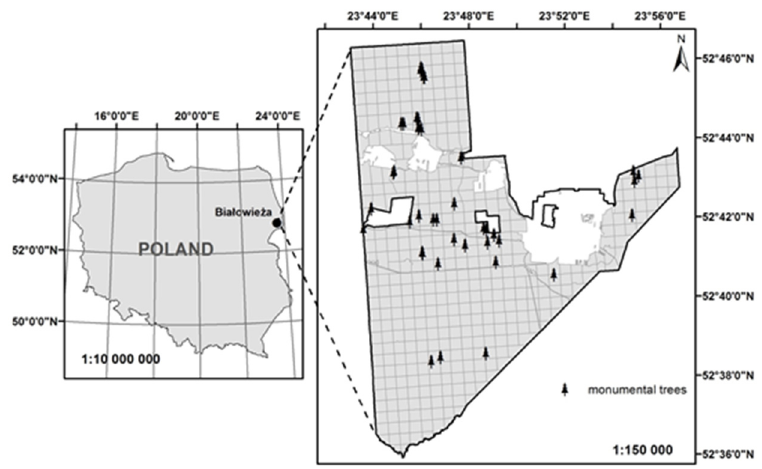
Figure 1. Geographical location of 47 Monuments of Nature (Population 1) in Białowie˙za Forest District (BFD) (a part of Białowie˙za Primeval Forest (BPF)). The other stands investigated (Populations 2–8) surrounded this site within 10 to 35